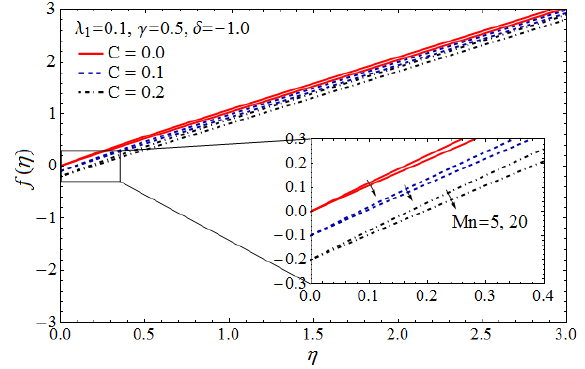
Fig. 3 Similarity profile f ( η ) for various values of Mn and C . The direction of the arrows represents increasing Mn.